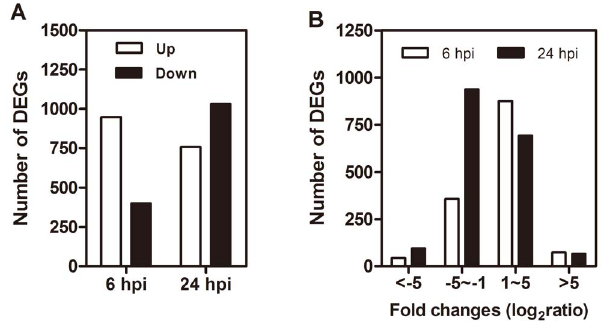
Figure 2. Analysis of differentially expressed genes. (A) An overview of differentially expressed genes (DEGs) between the whitefly libraries of 6 hpi and control, and of 24 hpi and control; the white and black bars indicate the up- and down- regulated genes, respectively. (B) The distribution of fold changes (log 2 ratio) of the DEGs.